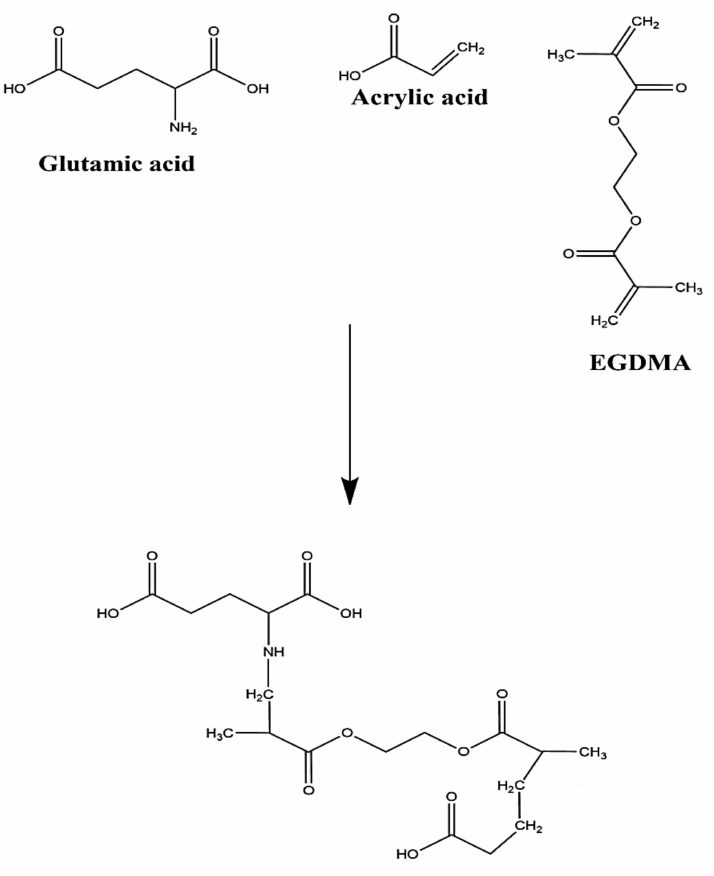
Figure 1. Proposed chemical structure of GAcPAAc